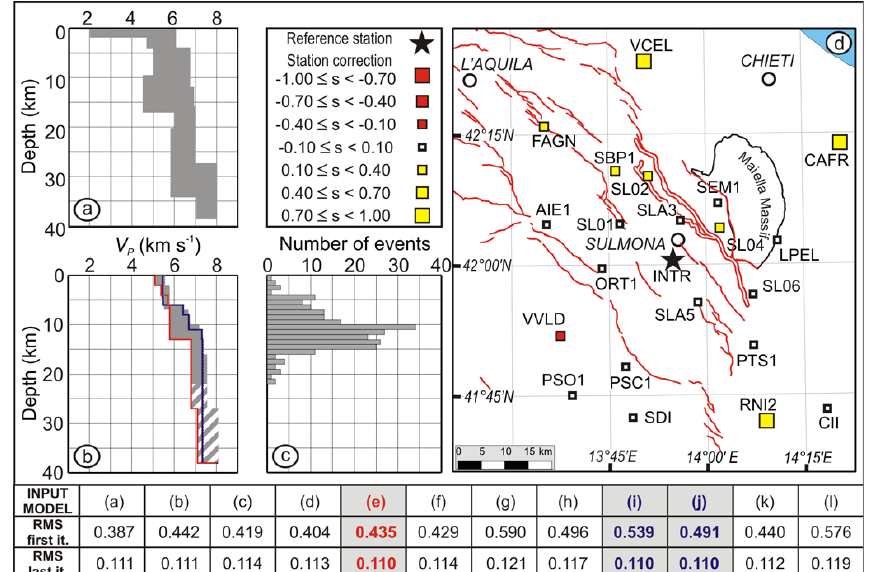
Fig. 7. 1-D velocity model in the Sulmona area. (a) Envelope (e.g. range of variability) of the starting P -wave velocity models individually plotted in Fig. 6. (b) Envelope (e.g. range of variability) of the best 1-D velocity models computed with the Velest code having a misfit less than or equal to 0.1s. The striped area represents the unconstraint depth interval of the velocity models. (c) Depth distribution of the selected events (Fig. 2) used to compute the velocity model. (d) Location map of the seismic network with station corrections related to the best model; positive values correspond to velocity slower with respect to the model. In the table the start and final RMS travel-time residual for each of the 12 used models ( a–l in Fig. 6) are